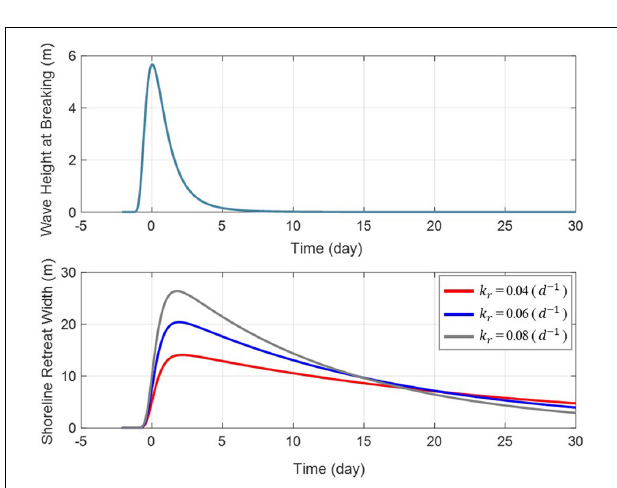
FIGURE 5 | A curve showing the correlation between SL position and energy obtained from Dean’s equilibrium beach profile formula.